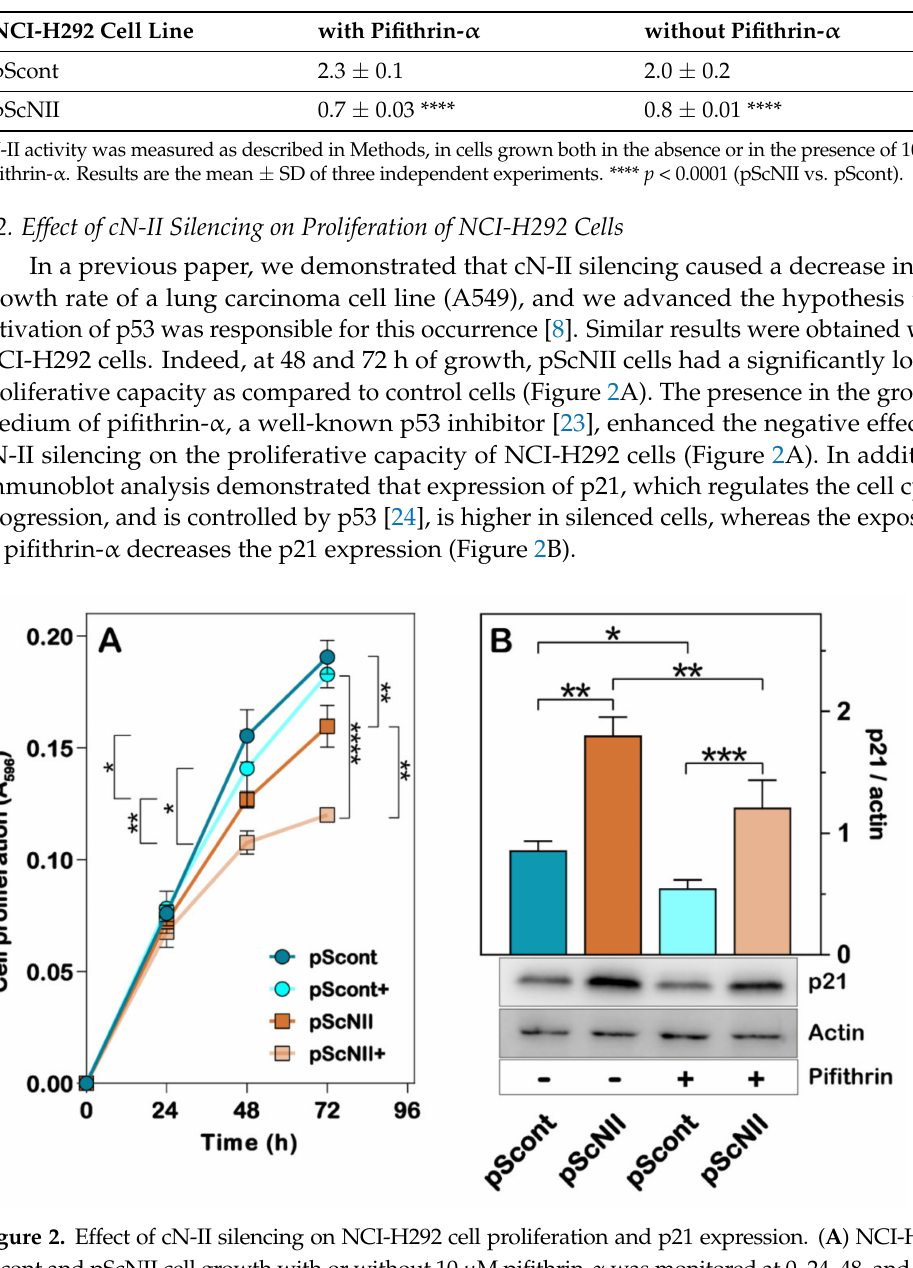
Table 1. cN-II activity (mU/mg) in NCI-H292 cells.